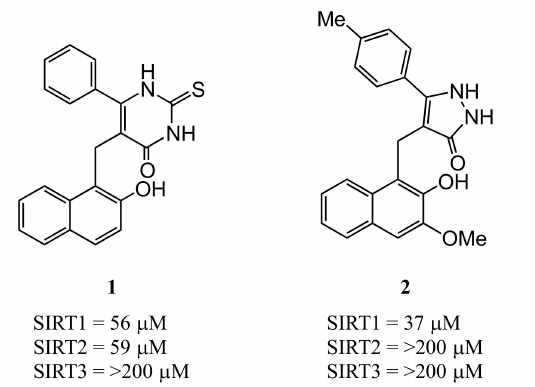
Figure 1. Cambinol ( 1 ) and its pyrazolone analog ( 2 ) showing improved SIRT1